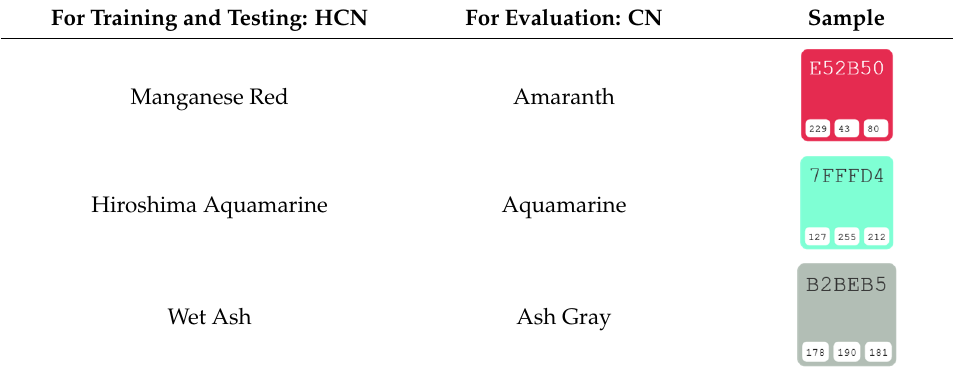
Table 4. Example of color names for the same color in different databases. For Training and Testing: HCN